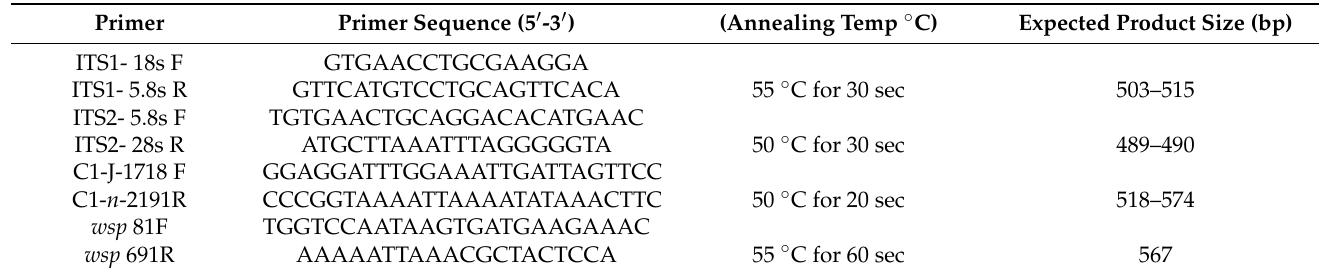
Table 1. Primers and annealing temperature used for